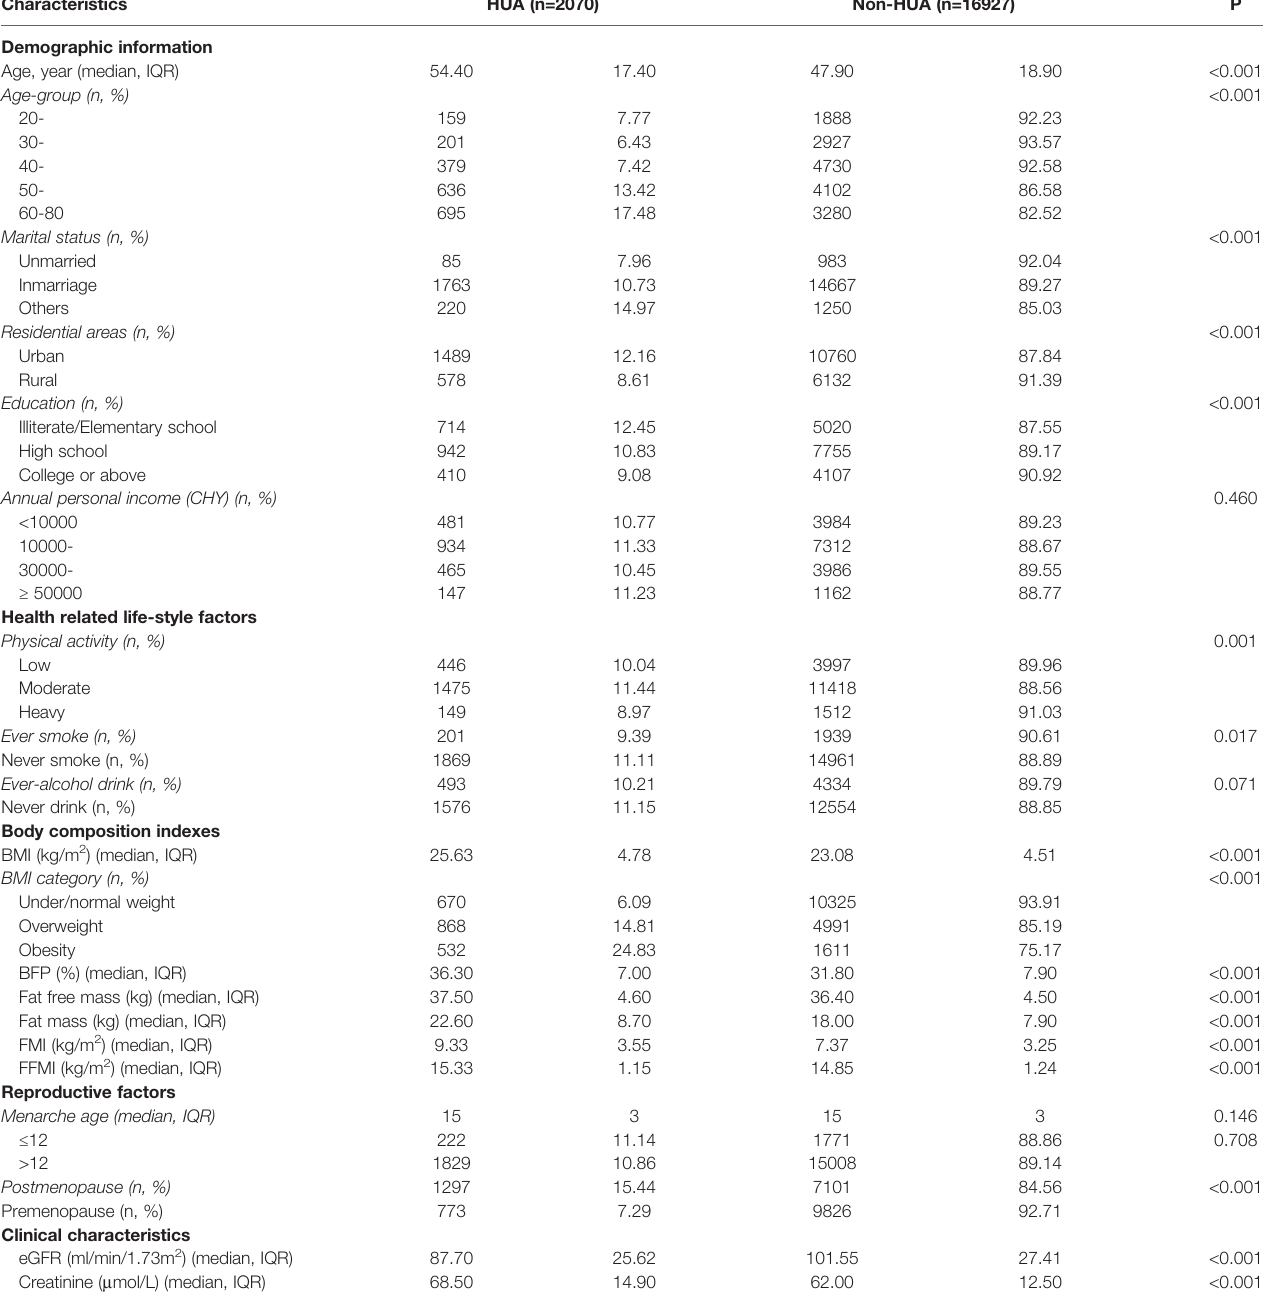
TABLE 1 | Basic characteristics of the study population in CNHS (n=18997). Characteristics Demographic information Age, year (median,